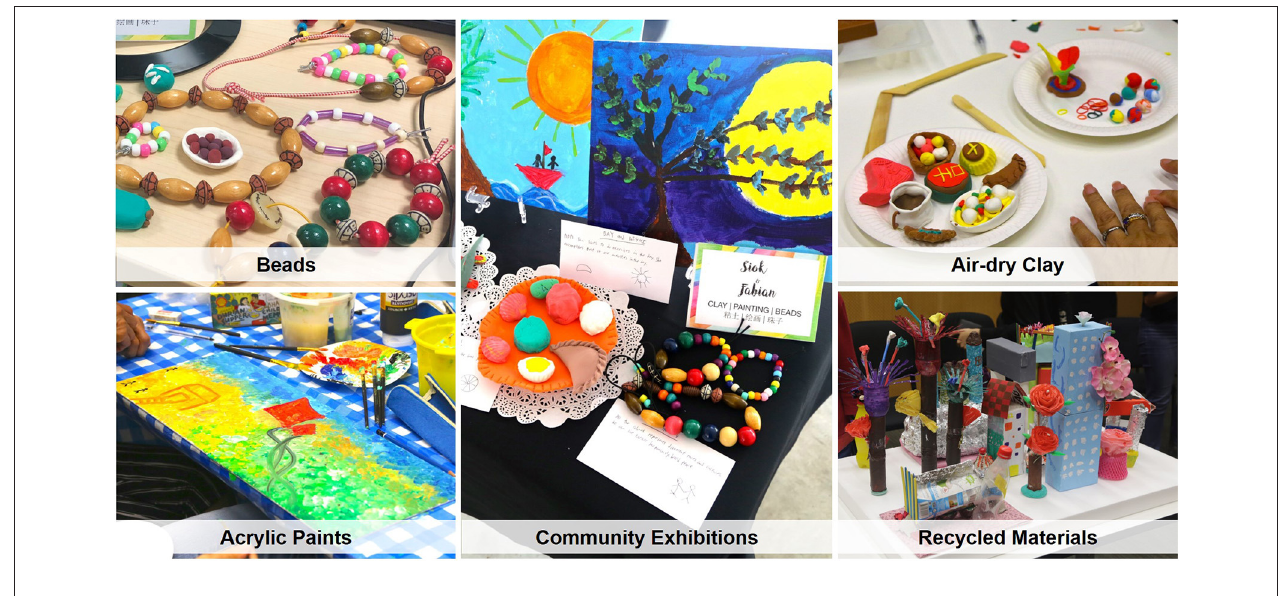
FIGURE 1 | Sample art mediums for the ARTISAN intervention.